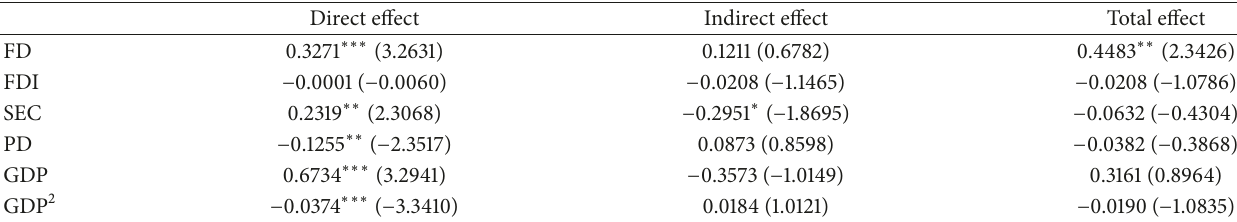
Table 7: Direct and indirect effects of spatial Durbin model with spatial fixed